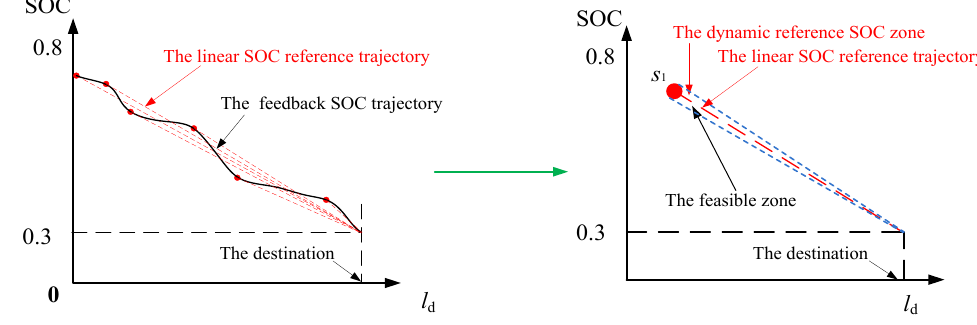
Figure 5. The principle of the dynamic SOC design zone method.